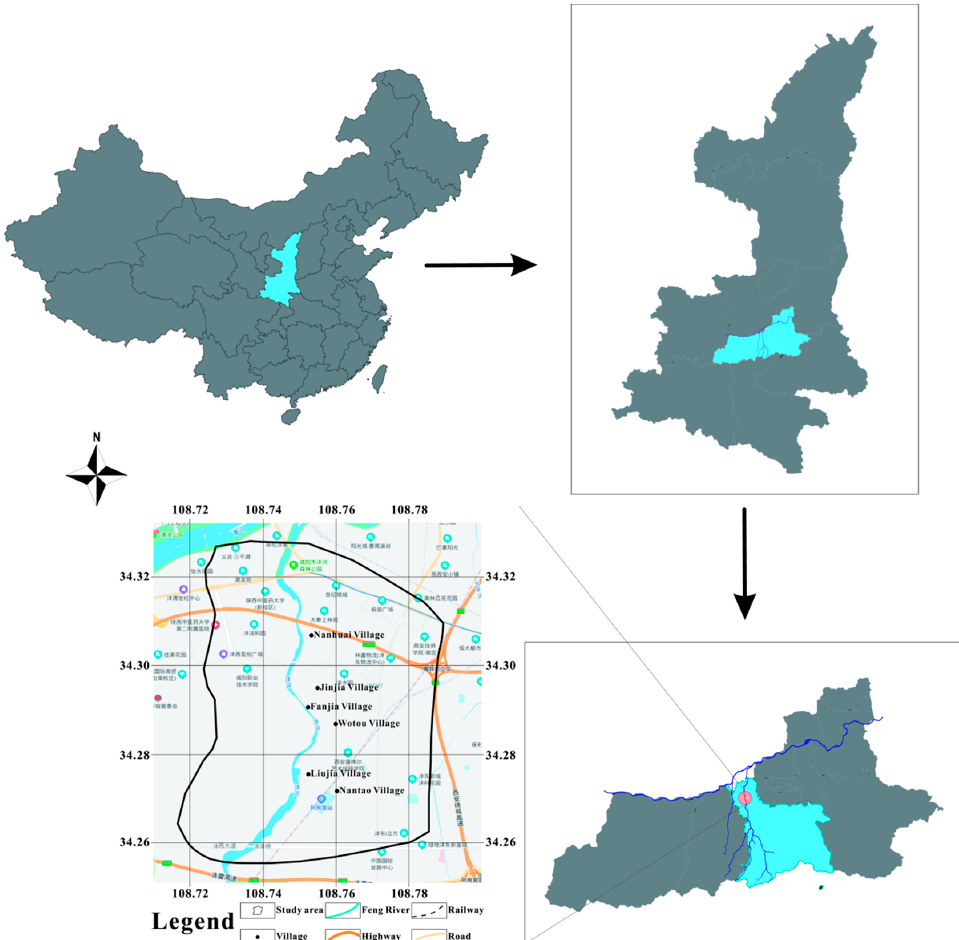
Figure 2. Study area.